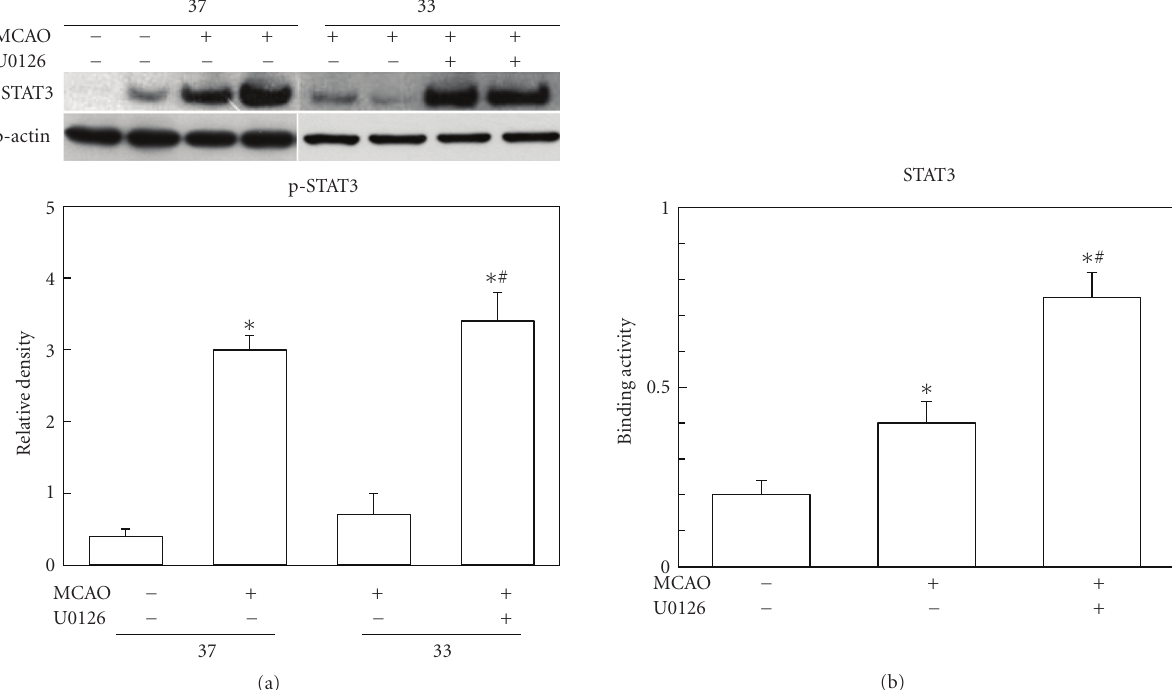
Figure 4: E ff ect of ERK1/2 inhibition on the STAT3 phosphorylation and DNA binding activity. (a) Western blot analysis demonstrates that STAT3 activation at 2 hours after ischemic insult is increased in normothermic group (37, n = 6). This increase was reduced by hypothermia (33, n = 6). In hypothermic group, U0126 treatment (33, n = 4) enhanced STAT3 phosphorylation to the level of normothermia group (37, n = 6). ∗ P < . 05 versus sham; # P < . 05 versus hypothermic ischemia without U0126. (b) DNA binding activity assay of STAT3 using nuclear fraction from ischemic brain under hypothermia condition shows increased binding activity of STAT3 at 2 hours after MCAO ( n = 4). STAT3 binding was further augmented by U0126 treatment ( n = 4). ∗ P < . 05 versus sham; # P < . 05 versus ischemia without